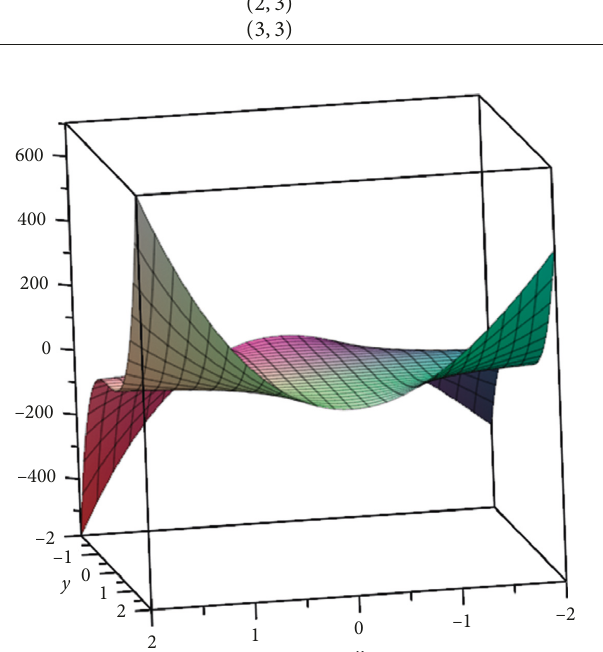
Figure 4: The graph of M-polynomial of O